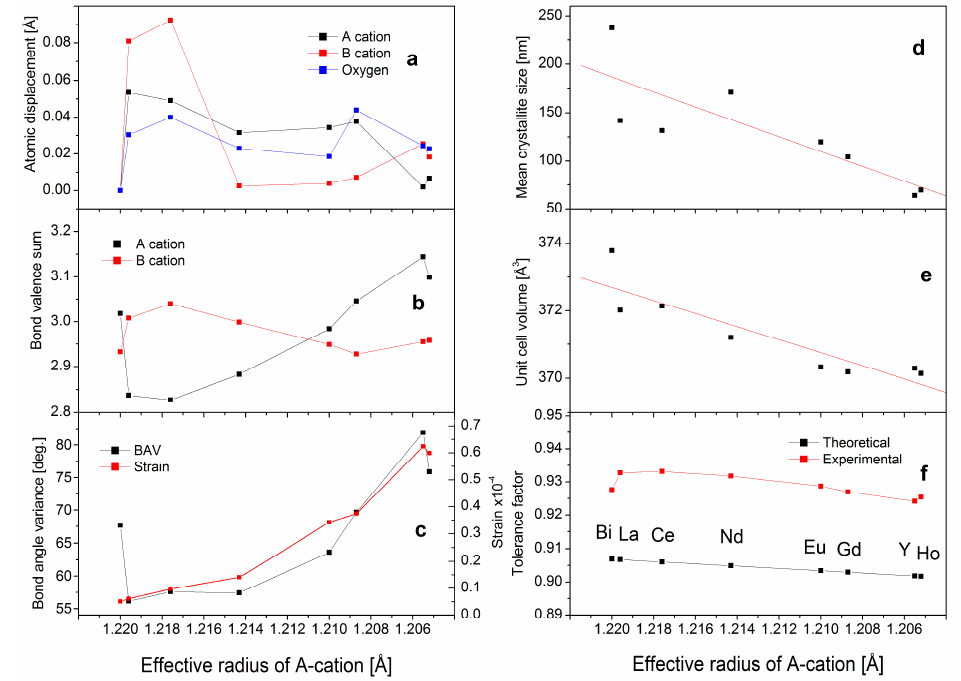
Figure 4. Structural parameters and indicators for the changes in BiFeO 3 structure upon substitution of Bi by 0.1 RE (RE = La, Ce, Nd, Eu, Gd, Ho, and Y). The dependences are related to the decrease of effective ionic radius in A-cation position. ( a ) absolute atomic displacement; ( b ) bond valence sums; ( c ) bond angle variance (left), strain (right); ( d ) mean crystallite size; ( e ) unit cell volume; ( f ) tolerance factor.